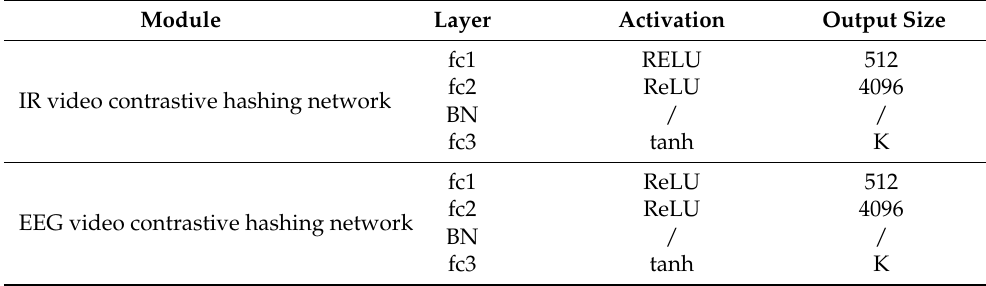
Table 2. Specific structure of the infrared sleep modality and EEG modality hashing module. Module Layer Activation Output Size fc1 IR video contrastive hashing network